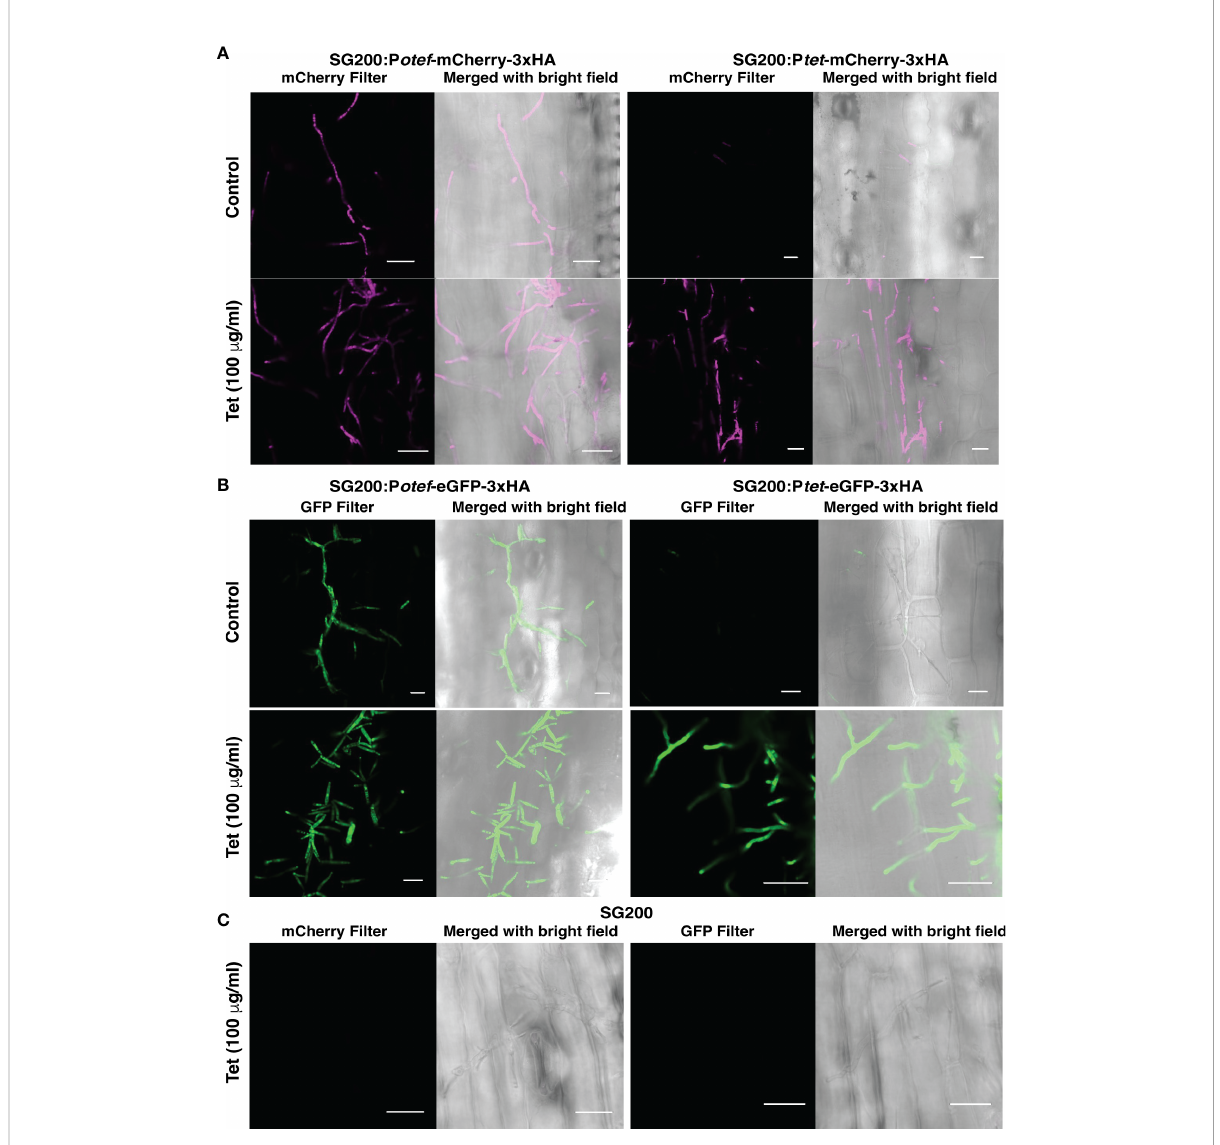
FIGURE 5 Tet-regulated expression of mCherry and eGFP in infected maize plants. (A) Expression of mCherry with P otef and P tet promoter in control and Tet-added maize plants at 3 dpi. (B) Expression of eGFP with P otef and P tet promoter in control and Tet-added maize plants at 3 dpi. (C) Maize infected cells showing hyphal growth of progenitor strain SG200 at 3 dpi in Tet-added condition (Scale bar = 20 m